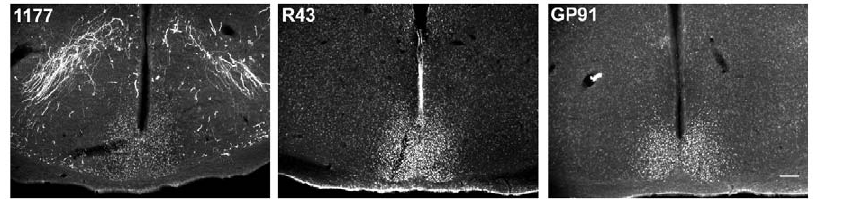
Figure 4. Photomicrographs of hamster SCN sections immunostained with PER1 antibodies. PER1 antibodies R1177, R43 and GP91 were used at a concentration of 1:5,000. Animals were euthanized at ZT12. Scale bar, 100 m m.